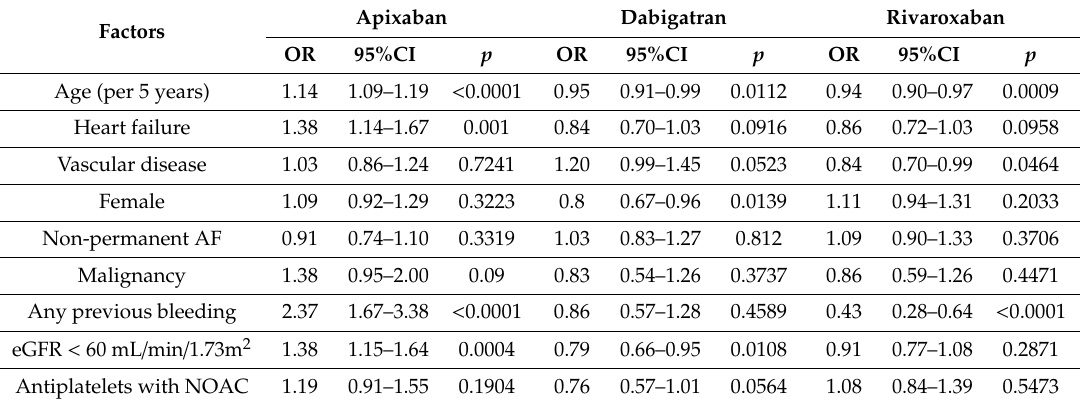
Table 4. Factors associated with the selection of an individual NOAC over another NOAC for stroke prevention in patients with AF, assessed using multivariable logistic regression models (participating centers were included as potential